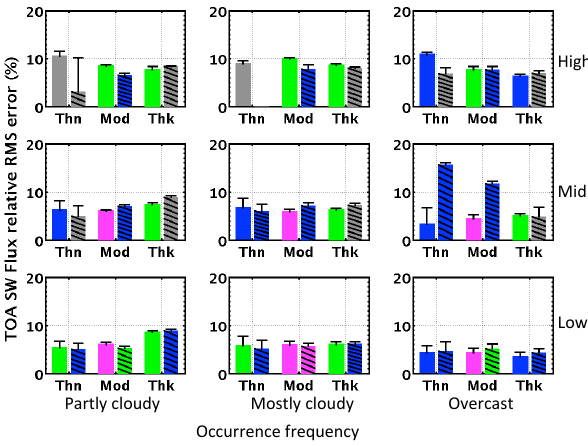
Figure 17. Same as Fig. 15, but over snow and ice.